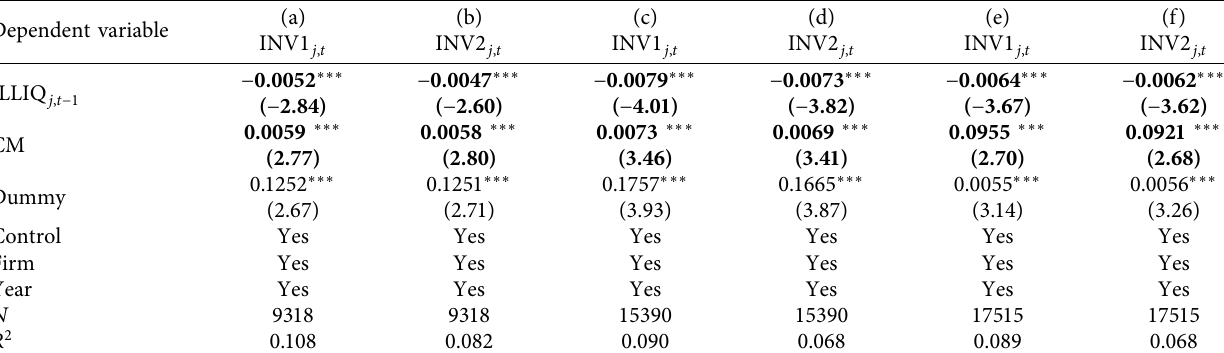
Table 12: Verification of the microlink between stock liquidity and enterprise investment by macropolicies (margin trading group is to verify the impact of stock illiquidity on enterprise investment before and after the margin trading policy, so the sample of stocks not participating in margin trading is deleted, and the number of samples is 9334. Similarly, the share-trading reform group deleted the data of stocks that had not participated in the share-trading reform, leaving 15390